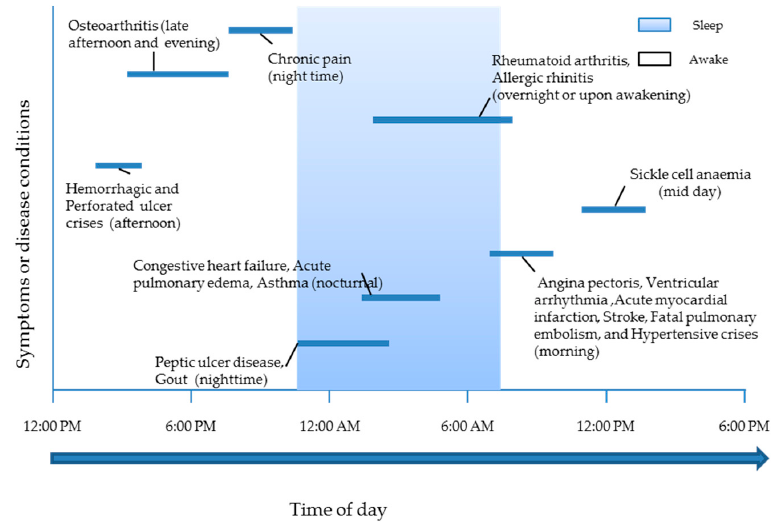
Figure 2. Time of day when symptoms or events of diseases are most frequent [16,17].